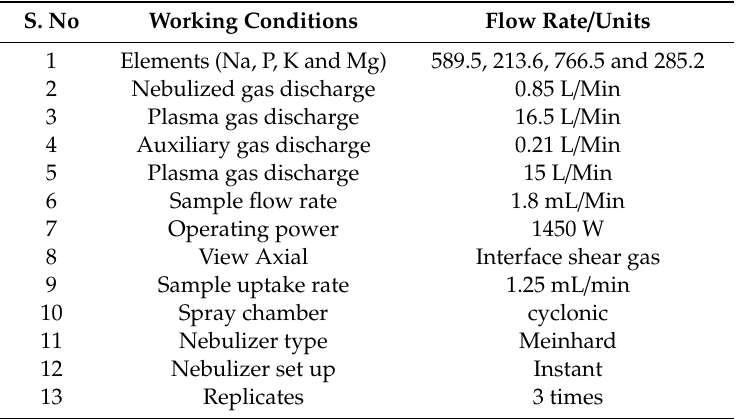
Table 1. Conditions of plasma-optical emission